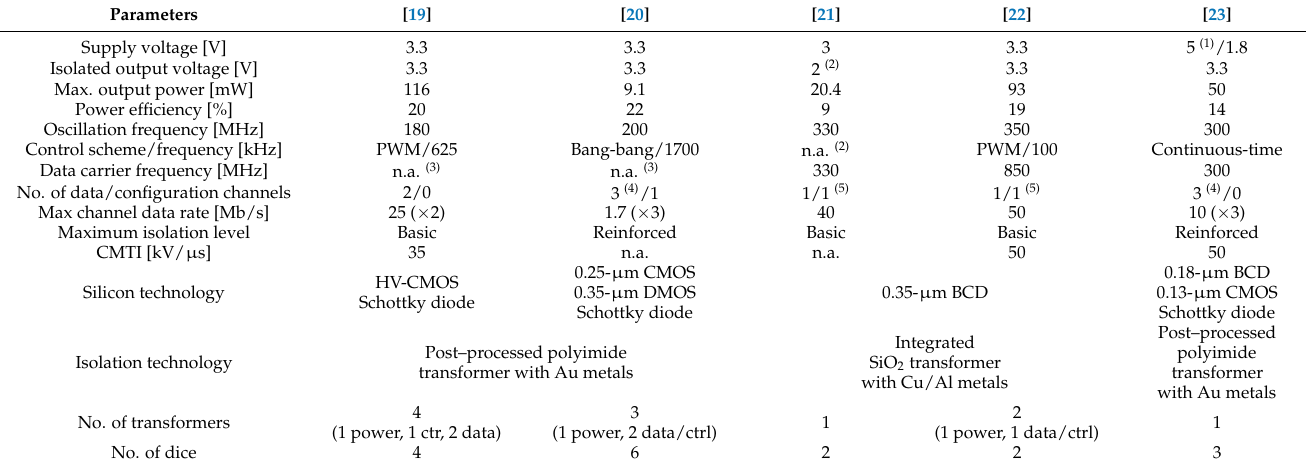
Table 1. Performance comparison of DC-DC converter architectures for low-power isolated